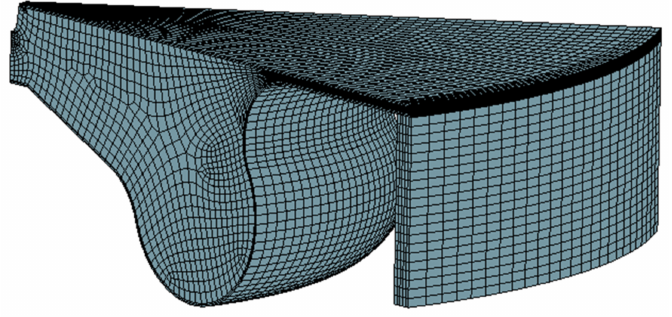
Figure 2. Geometry of the computational domain at the top dead center of the ICE.